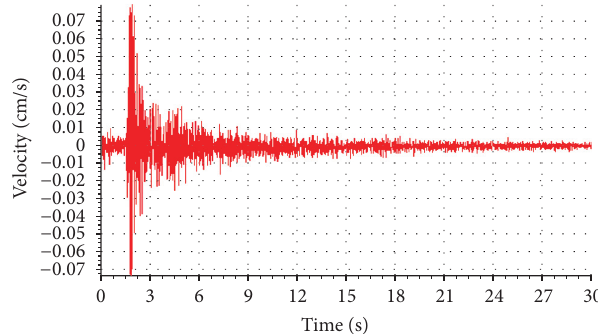
Figure 9: Input ground motion of Skellefte˚a earthquake (normal case).